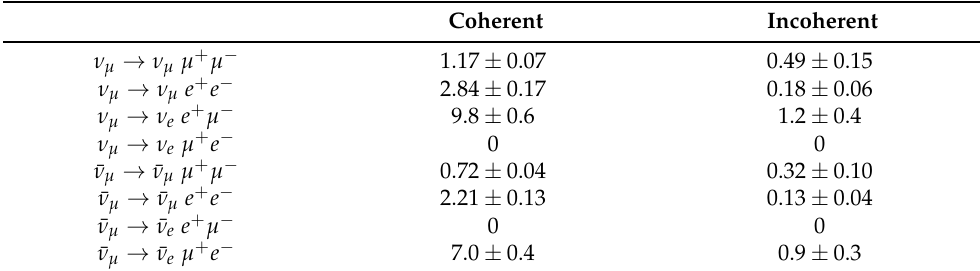
Table 22. Expected number of ν µ (¯ ν µ )-induced Standard Model trident events at the DUNE near detector per ton of argon and year of operation in neutrino mode (first four rows) or antineutrino mode (last four rows).